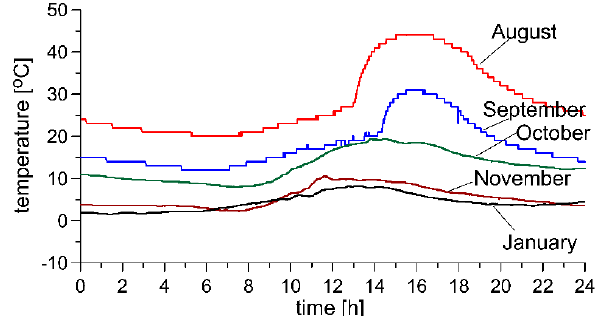
Figure 2. Daily temperature variability of pavement in selected months, in Polish climate conditions.